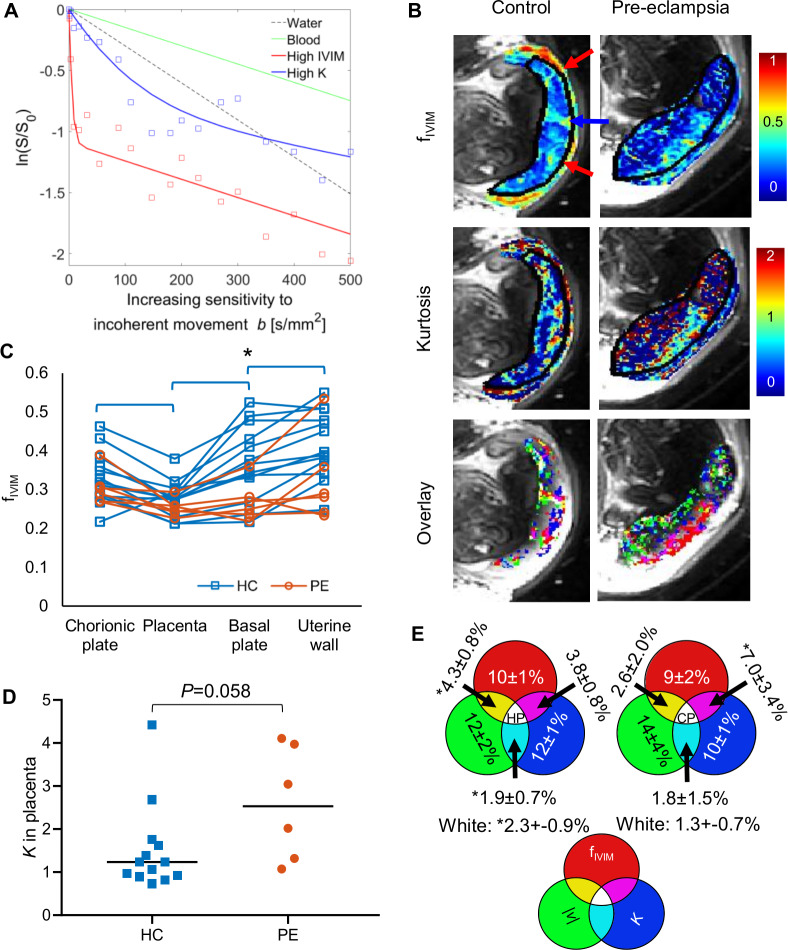
Incoherent flow in the placenta and its relationship to regions of high coherent flow.(A) Variation of signal with increasing sensitivity to incoherent movement (termed b-value in MRI). The black line shows the decay expected for unrestricted diffusion in stationary water. The green line illustrates slower decay typical of restricted diffusion by cells in blood samples [31]. The other curves show example placental data fitted to Eq 1. The red curve shows fast decay at low b-values caused by blood moving incoherently within a voxel, for instance, because of turbulence. The blue curve shows faster decay than expected due to diffusion in static blood, suggesting that flow is causing some incoherent motion in the voxel; the curvature indicates non-Gaussian diffusion consistent with percolation through a porous medium. (B) Maps of fIVIM, kurtosis, and overlaid masks of voxels with highest 20% of values of fIVIM, K, or |v| for HC3 and PE6. The red and blue arrows correspond to the arrows on Fig 2A. (C) Scatterplot showing average values of fIVIM in the chorionic plate, placenta, basal plate, and uterine wall ROIs for each participant (* indicates significant difference between HC and PE; brackets indicate significant difference between ROIs for HC participants only, S3 Table). (D) Kurtosis in the placenta region for HC and PE; the black line indicates the median. (E) Venn diagrams indicating top 20th centile of voxels in each primary ROI for both the HC and PE groups (mean ± standard deviation). *Value differs from value expected by chance by more than interparticipant standard deviation. Underlying data plotted in panels A, C, and D are provided in S1 Data. fIVIM, IVIM fraction; HC, healthy control pregnancy; IVIM, intravoxel incoherent motion; MRI, magnetic resonance imaging; PE, preeclamptic pregnancy; ROI, region of interest.